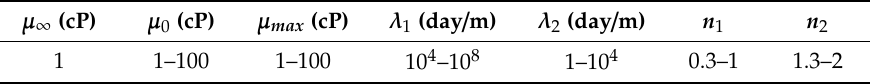
Table 3. Carreau parameter intervals used for automatic history match operations in